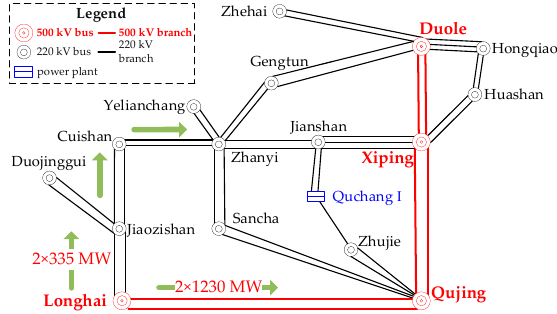
Figure 6. Structure of Qujing Power Grid. Table 2. Single maintenance conditions in which the problem of insufficient thermal stability margin of lines will occur in Qujing Power Grid.